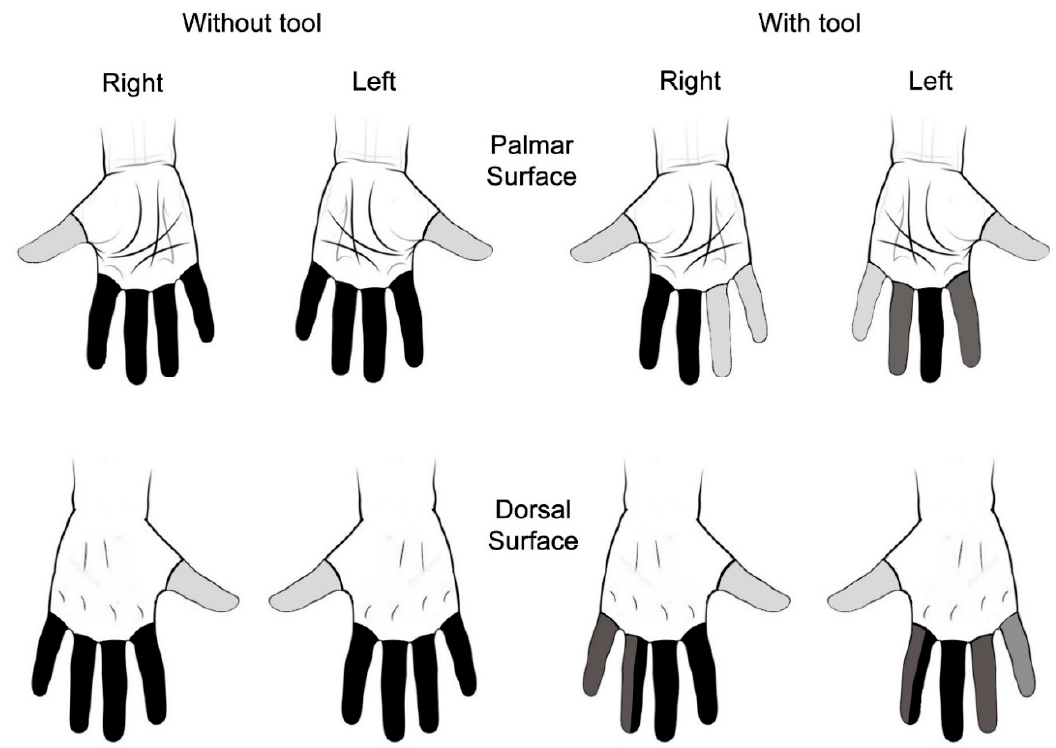
Figure 2. Difference between the finger temperatures in each hand, on the palmar and dorsal surfaces. Note: Fingers represented with distinct colors presented significant difference between the finger temperatures of each hand ( p < 0.001).